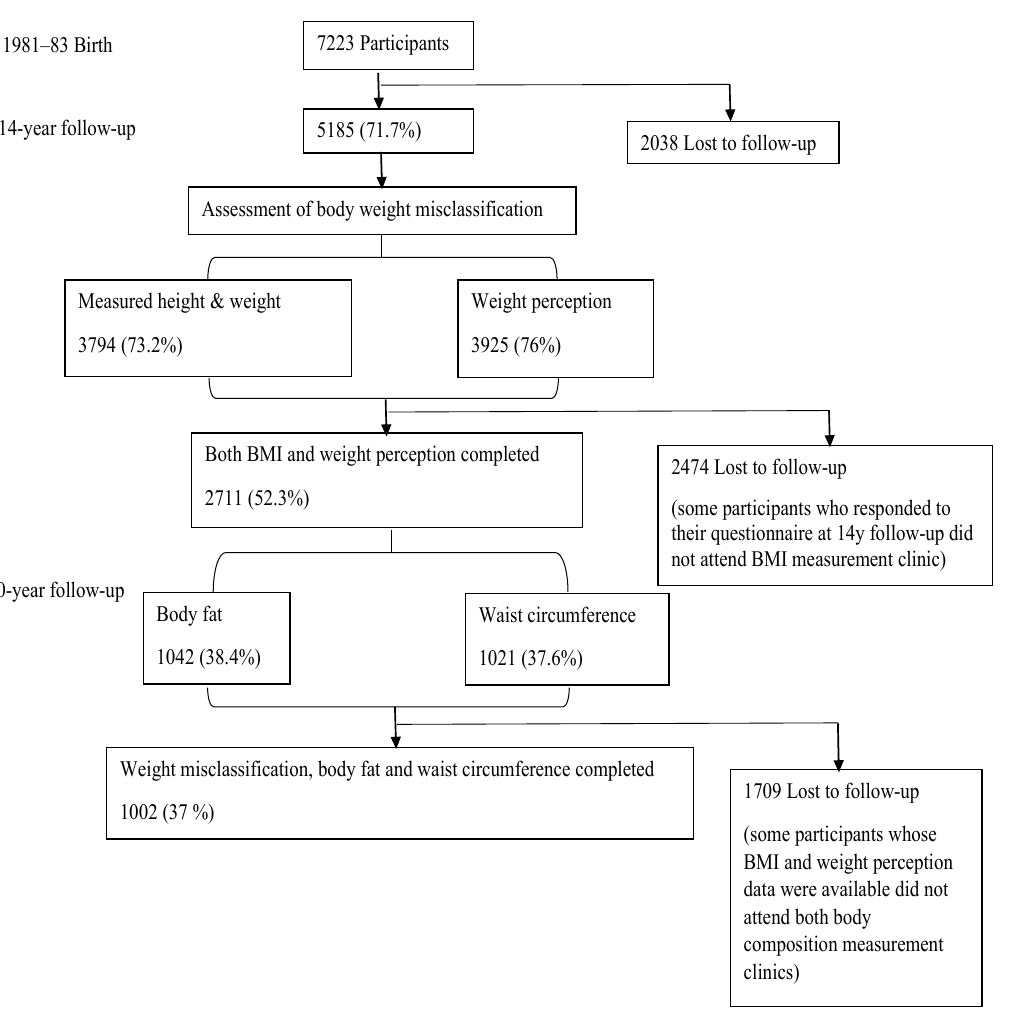
Figure 1. Flowchart of the MUSP cohort, body mass index, weight perception, and the analytical sample.